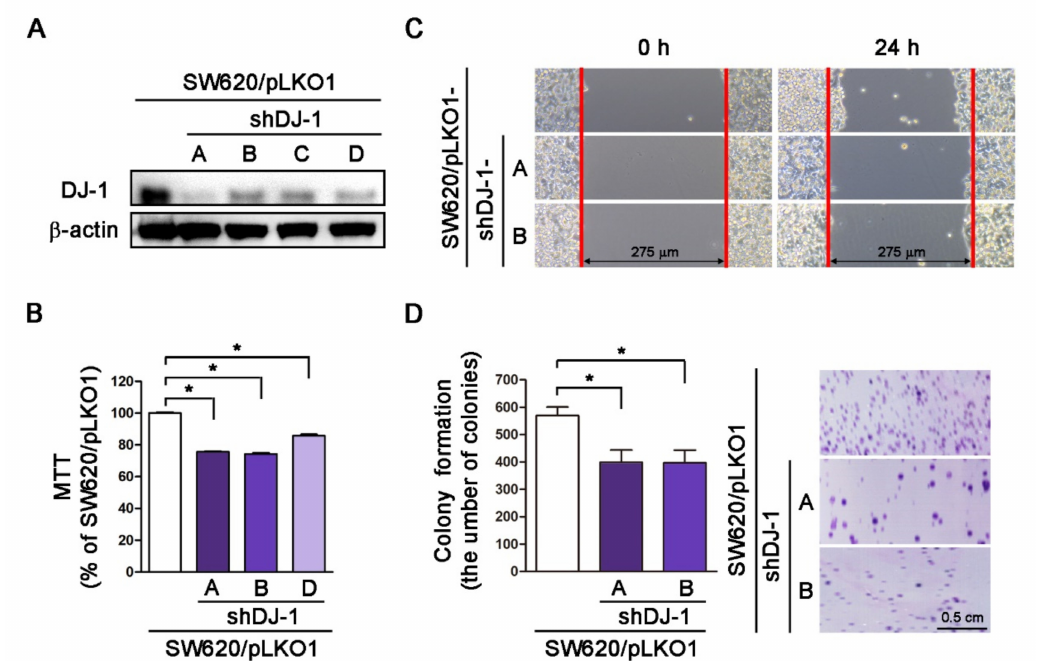
Figure 4. DJ-1 knockdown inhibits cell survival, cell migration, and colony formation in metastatic colorectal adenocar- cinoma cells. ( A ) The Western blot result shows that pLKO-1-shDJ-1 plasmids effetely inhibited DJ-1 expression in four SW620 stable knockdown cell clones (SW620/pLKO1-shDJ-1-A, -B, -C, and -D) then the empty vector-transfected control (SW620/pLKO1). ( B ) The cell viability result by MTT assay shows that three DJ-1 knockdown cell clones (SW620/pLKO1- shDJ-1-A, -B, and -D) reduced cell viability than control (SW620/pLKO1). ( C ) Twenty-four hours after standardized gaps (275 µ m) were created for cell migration between cells by 2-well cell insert, SW620/pLKO1-shDJ-1-A and -B showed slower cell migration than control. ( D ) The result of adhesion-independent cell proliferation by cancer cell colony formation shows that SW620/pLKO1-shDJ-1-A and -B were lower in colony numbers than control after 500 cells/6-well were seeded for 14 days. The images of the colonies stained with crystal violet are shown on the right panels. Quantitative data are expressed as the means ± S.E.M; the p -value was determined by one-way ANOVA/Newman-Keuls test. *: p < 0.05 compared with the control